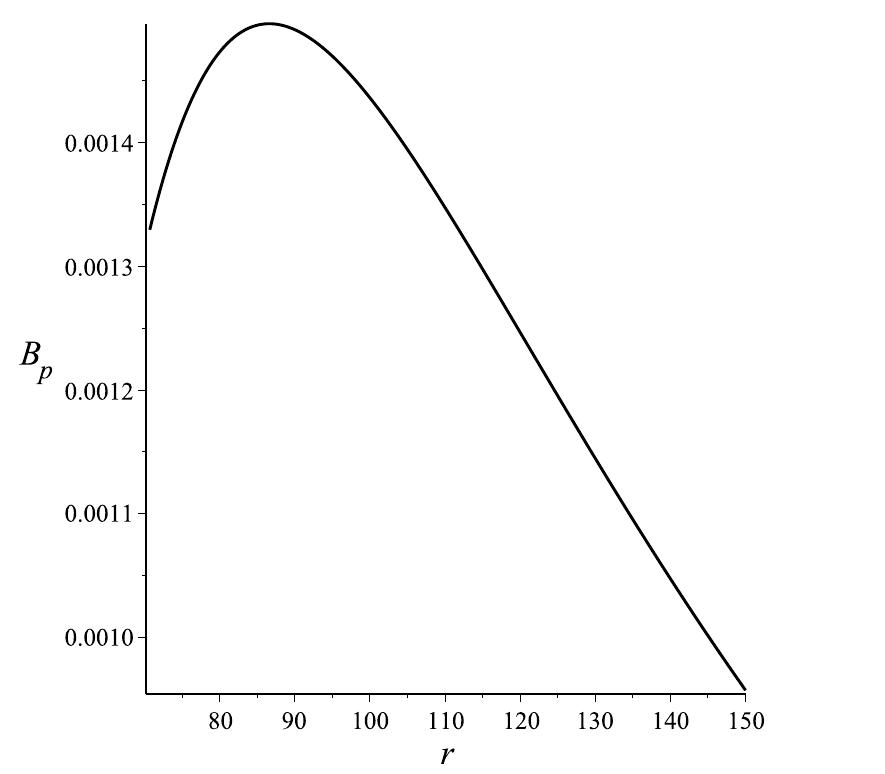
Figure 2 . The polar magnetic field B p , as a function of the radial coordinate outside the event horizon, for an extremal AdS 4 -Kerr-Newman magnetic black hole with L = 100 , a = 50 , P = 501 . 3 . (Units are Planck